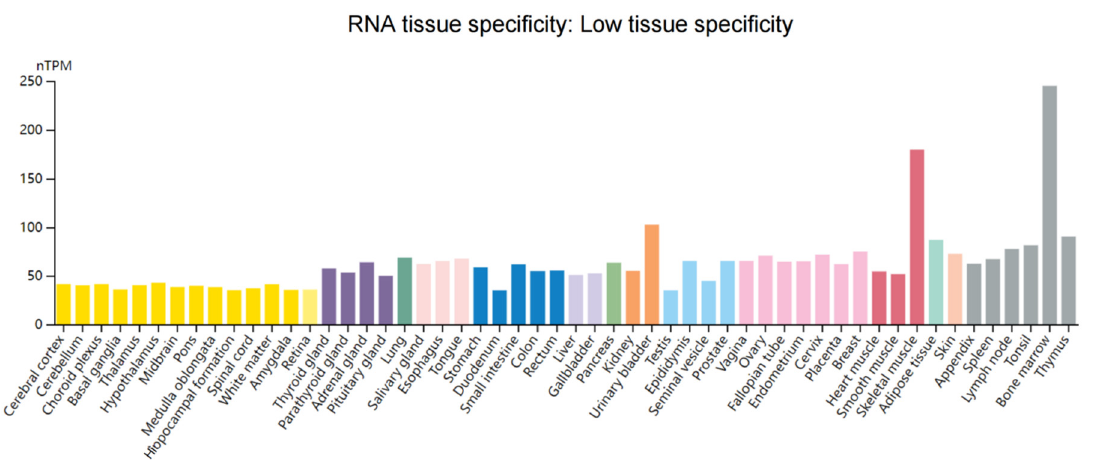
Figure 4. Overview of RNA expression of WTAP in human tissues. Normalized expression (nTPM) of 55 tissue types through the Human Protein Atlas online database (https://www.proteinatlas.org/ (accessed on 25 May 2022)). Data in the database are integrated from RNA-seq dataset of the Human Protein Atlas and RNA-seq dataset of the Genotype-Tissue Expression. Each color corresponds to a tissue with common functional characteristics.